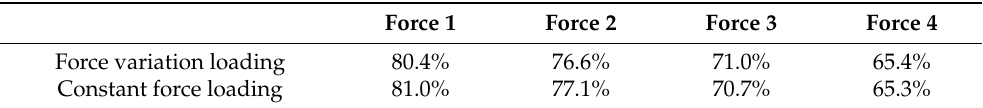
Table 6. Proportion of clean cutting surface contrast.